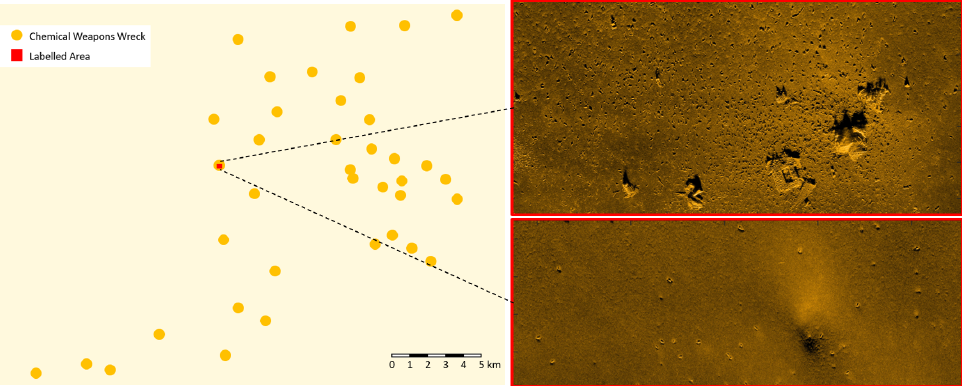
Figure 4. Suspected chemical weapons wrecks at Skagerrak [9]. The extent of the labelled area is barely visible at the scale of the full survey area. Two sonar views used for labelling are shown.